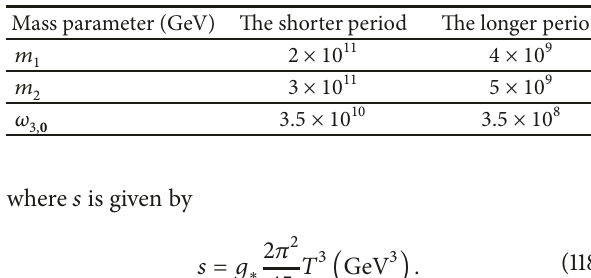
Table 2: The mass parameters in GeV unit for both longer and shorter period cases in Figure